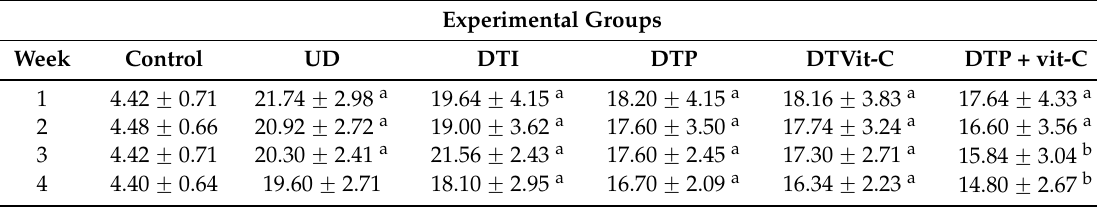
Table 1. Blood glucose concentrations of alloxan-induced diabetic rats treated with insulin, probiotic and vitamin